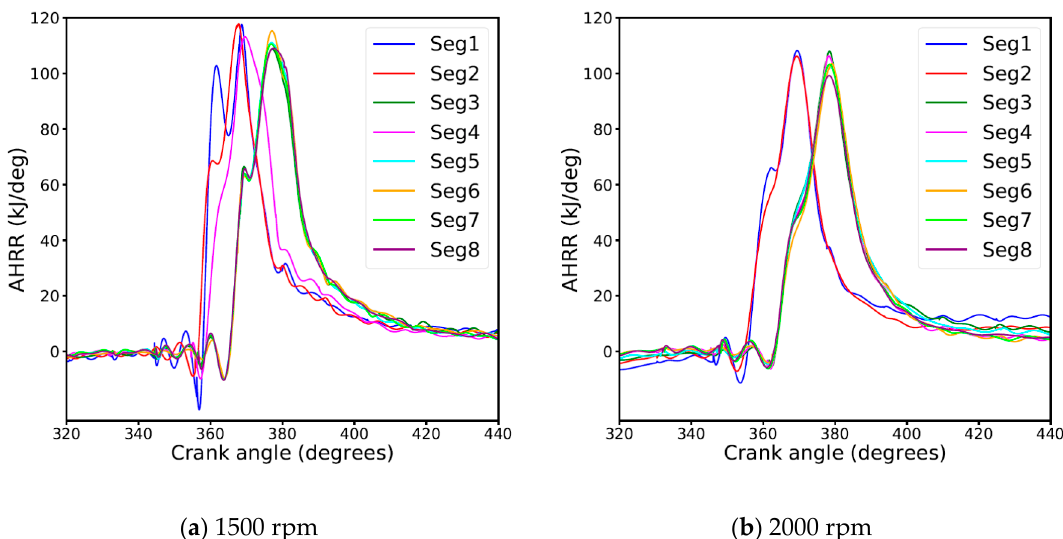
Figure 6. AHRR at 50% load in each segment in all stages at ( a ) 1500 rpm and ( b ) 2000 rpm. The blue line represents Segment 1, red line represents Segment 2, green line represents Segment 3, magenta line represents Segment 4, cyan line represents Segment 5, orange line represents Segment 6, lime line represents Segment 7 and purple line represents Segment 8.